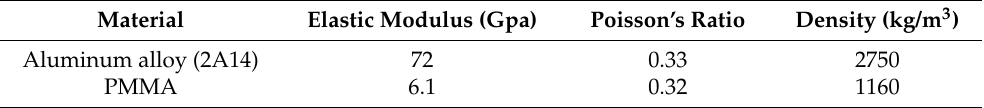
Figure 4. The two-dimensional physical model for L CR wave propagation. In this geometric finite element model, a section of the inclined end face of the left wedge was used as the excitation zone of the ultrasonic signal, and the corresponding section on the right wedge was used as the receiving zone of the ultrasonic signal. The length of the entire rectangle was 60 mm and the height was 40 mm. To simulate the excitation signal of the ultrasonic transducer, the length of the excitation zone of the signal on the left was set to 5 mm, which was the same as the diameter of the wafer used in the experiment, where the material of the plate consisted of 2A14 aluminum alloy. The material for the transmitting and receiving wedges on both sides consisted of PMMA, and the specific properties are shown in Table 2. Table 2. Test material